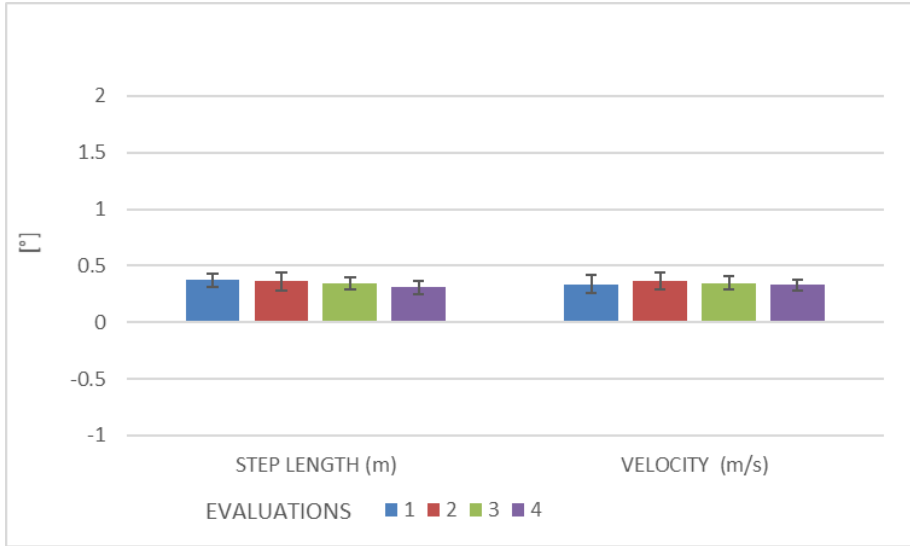
Figure 2. Spatio-temporal gait variables (step length and velocity) expressed as mean and standard deviation.